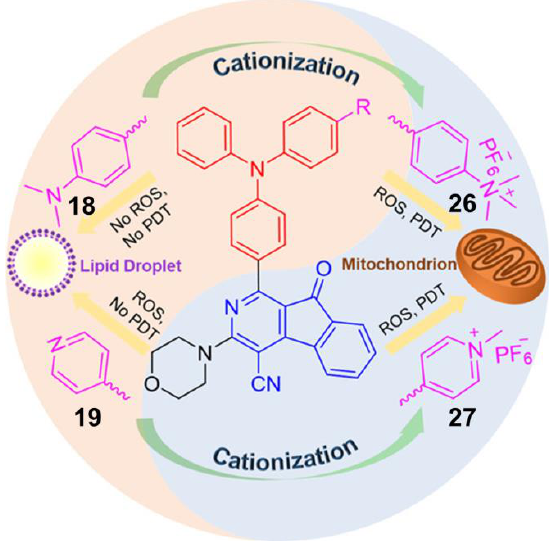
Figure 9. Chemical structures of AIE – PSs 18 , 19, 26, and 27 (among them, 18 and 19 have low ROS generation efficiency, and 26 and 27 with cations can have high ROS generation efficiency). Adapted and modified with permission from reference 13 (copyright 2019, American Chemical Society).